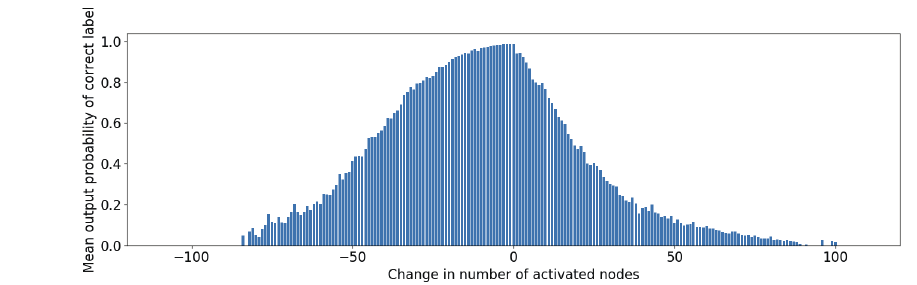
Figure 3: Simulation of relationship between the change in the number of all layers’ activated nodes and the mean output probability of the correct label in the MLP model with ReLU.